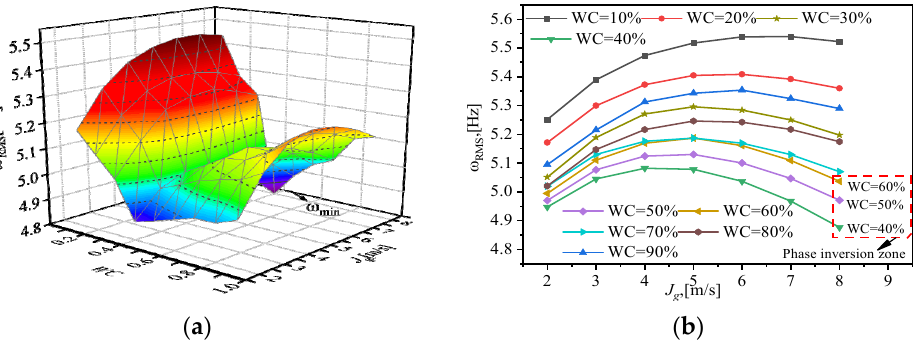
Figure 9. Effect of WC and J g on natural frequency at J L = 1.5 m/s: ( a ) The cloud diagram of natural frequency variation with WC and J g ; ( b ) Natural frequency variation with J g .